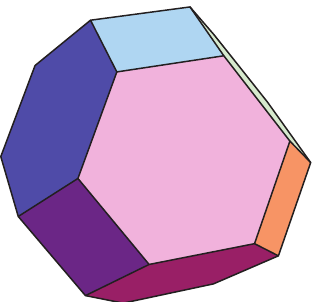
Figure 4. Truncated octahedron or tetrakaidecahedron, the basic unit for a space-filling network, proposed by Thomson 17 . This polyhedron has 14 faces: 8 hexagons and 6 squares.